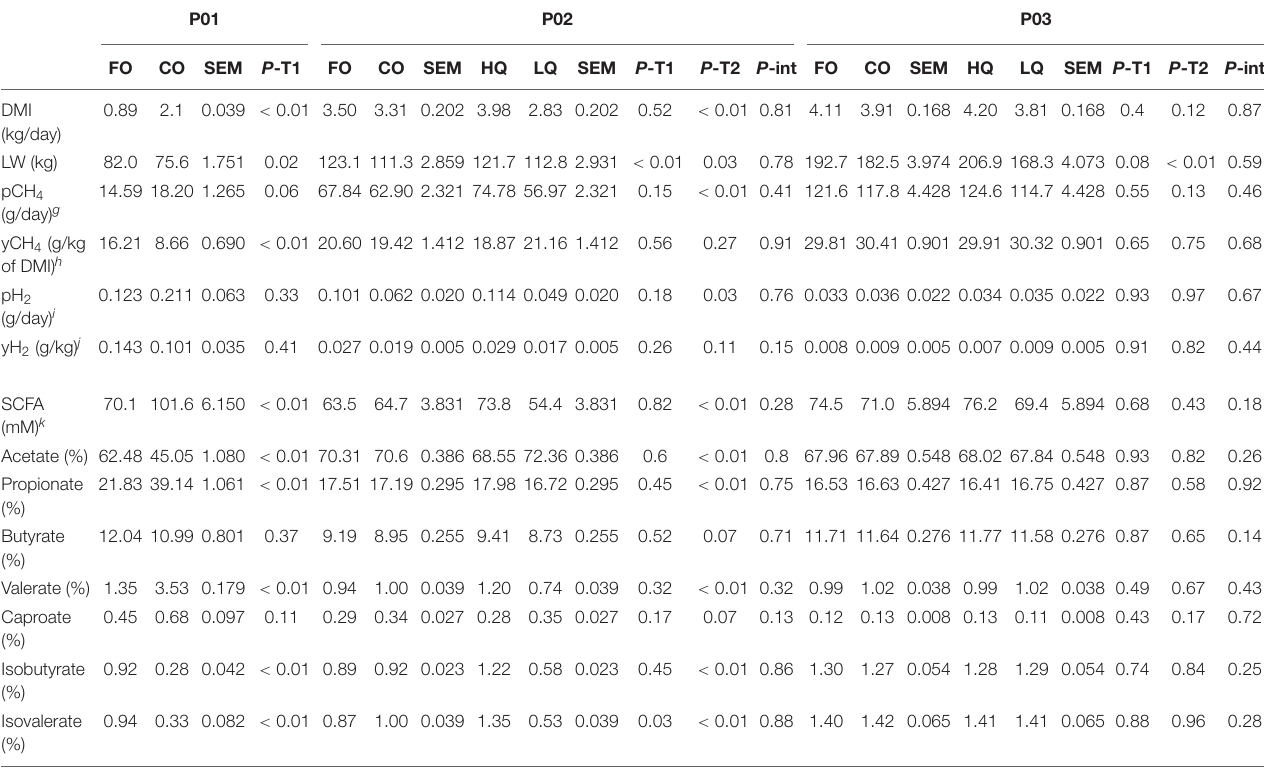
TABLE 2 | Effect of dietary treatments a on dry matter intake (DMI) b , live weight (LW) c , enteric emissions d , and fermentation profiles e in calves during three measurement phases f